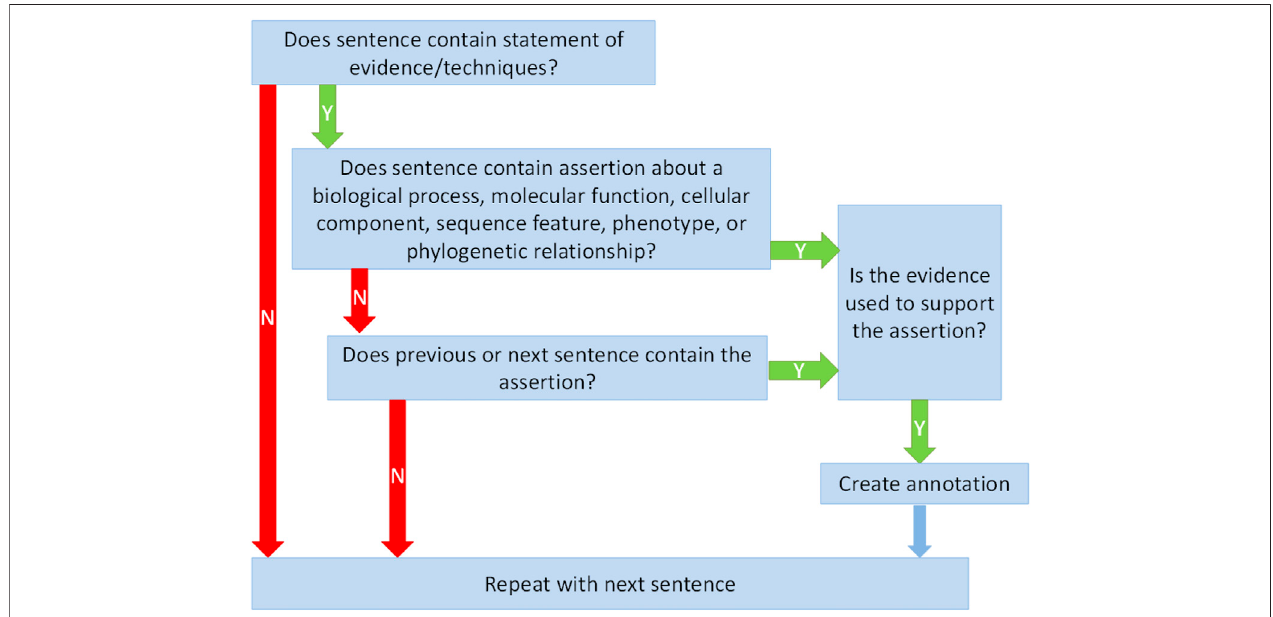
FIGURE1| Schematicoftheevidencestatementannotationprocess.Boxesindicatequestion-basedstepsintheannotationprocess.Arrowsshowthealternative fl ow-paths. Only evidence statements that are used to support a speci fi c set of types of assertions are annotated.